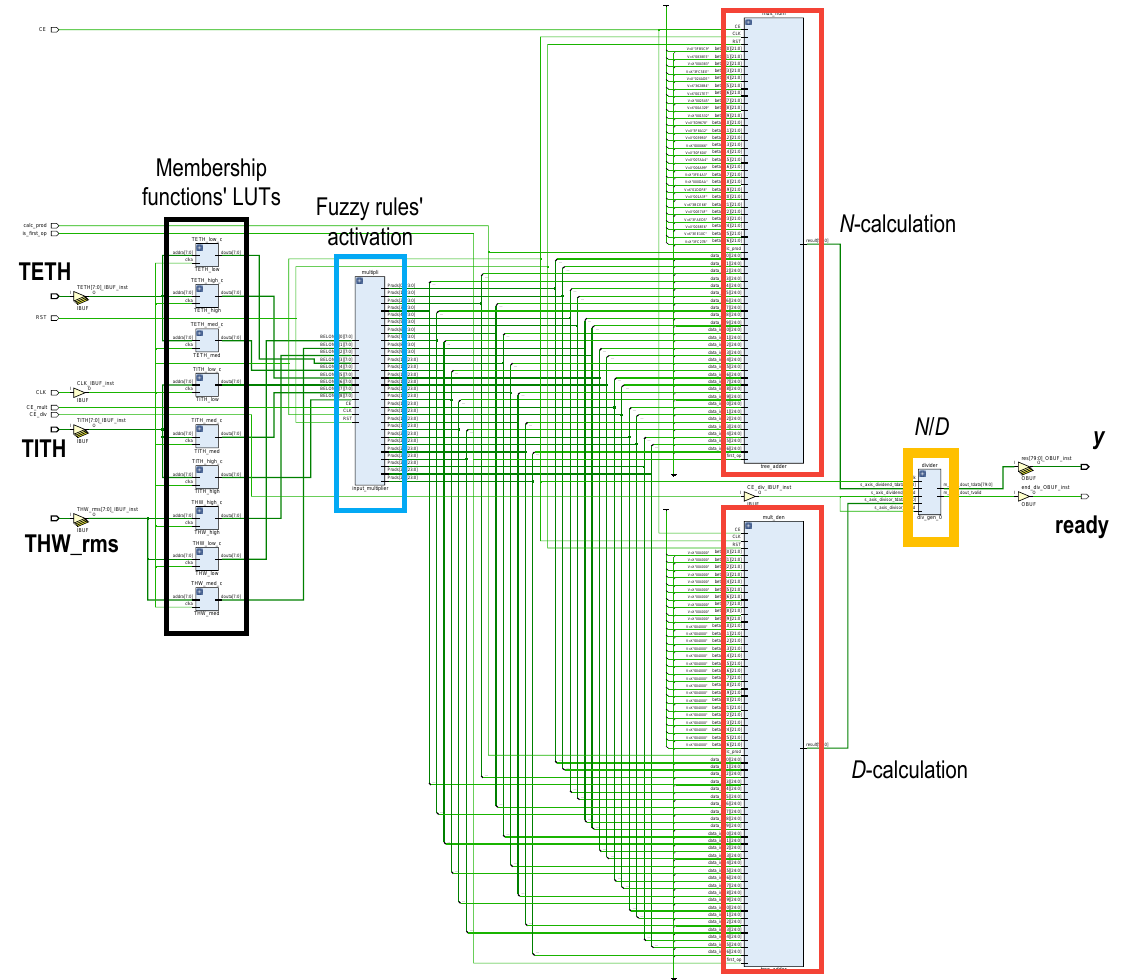
Figure 8. Block scheme of the parallel architecture of a three-input ANFIS implemented in the programmable logic (PL) of the programmable system-on-chip (PSoC). Three ANFIS cores, one per cluster, were implemented in the HW